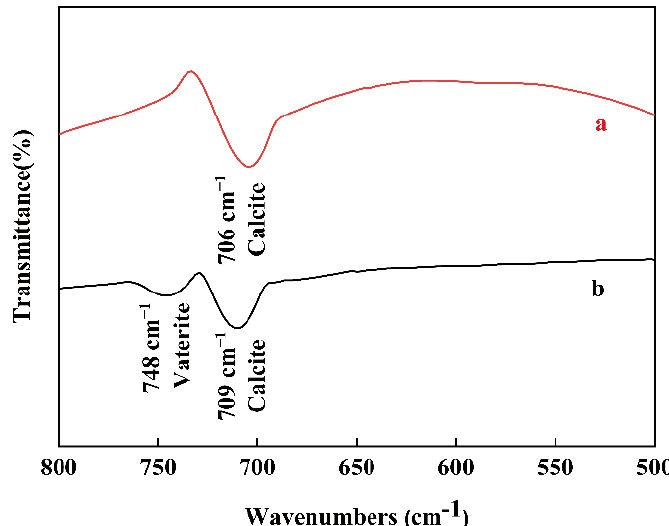
Figure 5. FT ‐ IR spectra of CaCO 3 obtained after 4 h in deionized water containing nanobubbles (a) and deionized water (b).